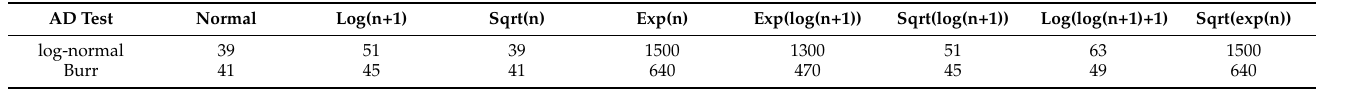
Table 12. Batch by split count, ST ≤ 1 second, filter >2, zero removed.